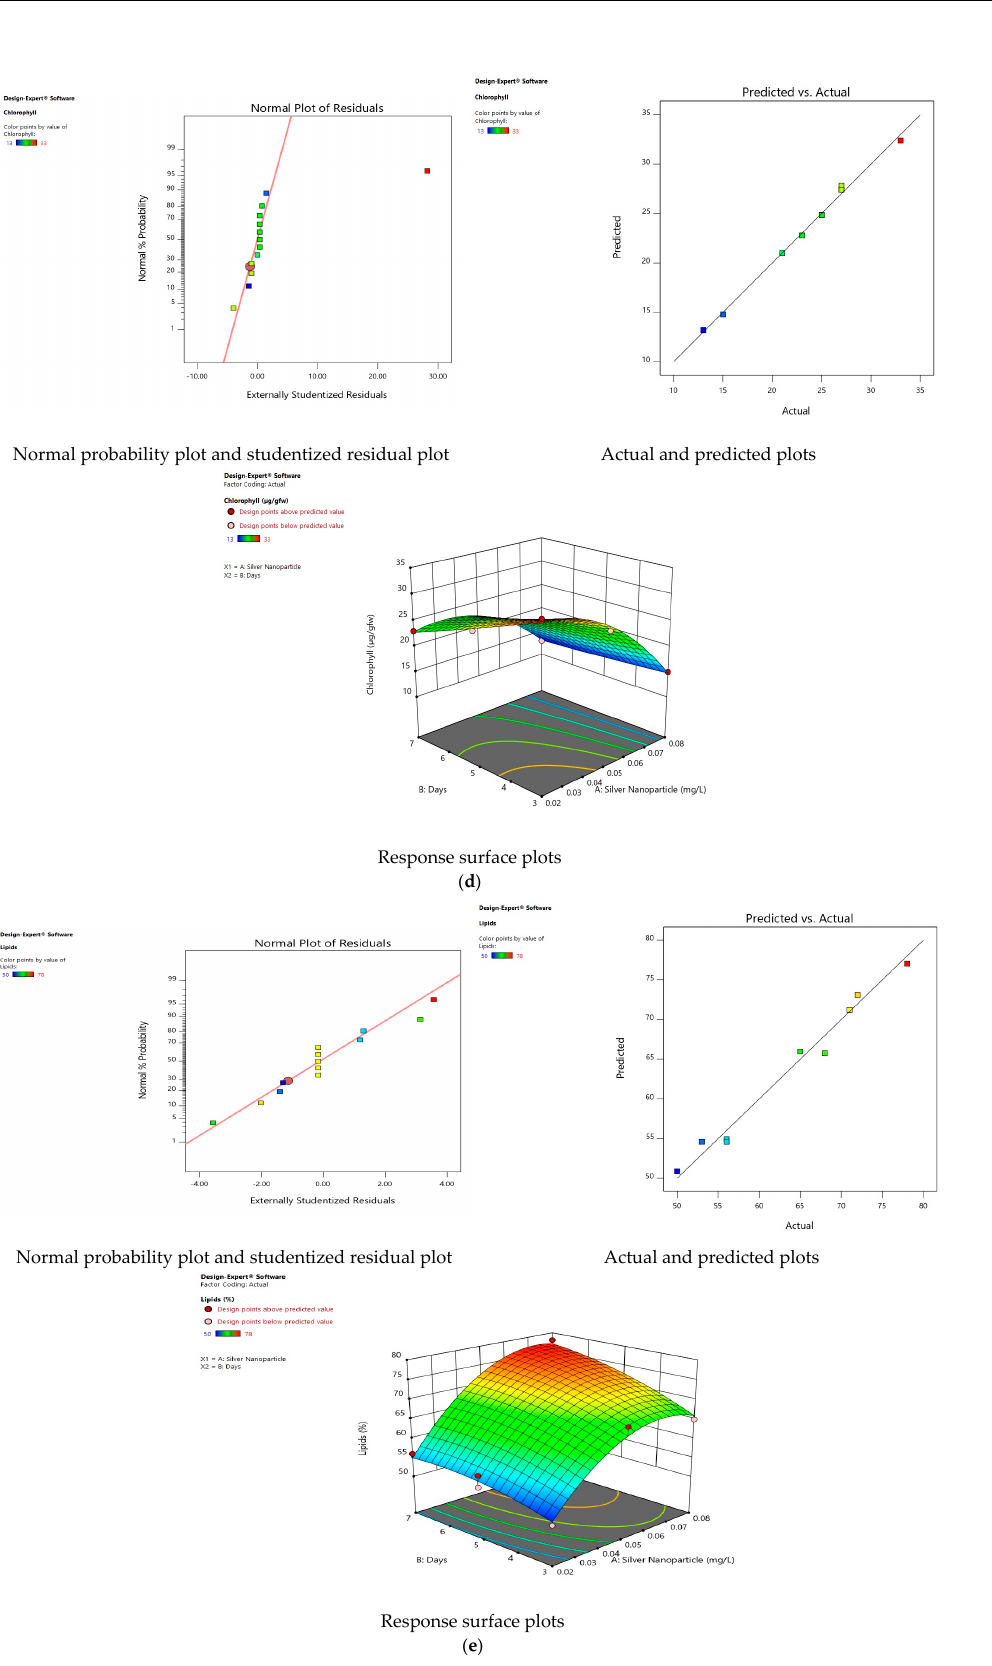
Figure 2. Response surface plots of ( a ) growth, ( b ) carbohydrates, ( c ) proteins, ( d ) chlorophyll and ( e ) lipids in Ulothrix sp. Color based on response value, as blue color shows the minimum points and red color shows the maximum points, pink color indicates points below predicted value.